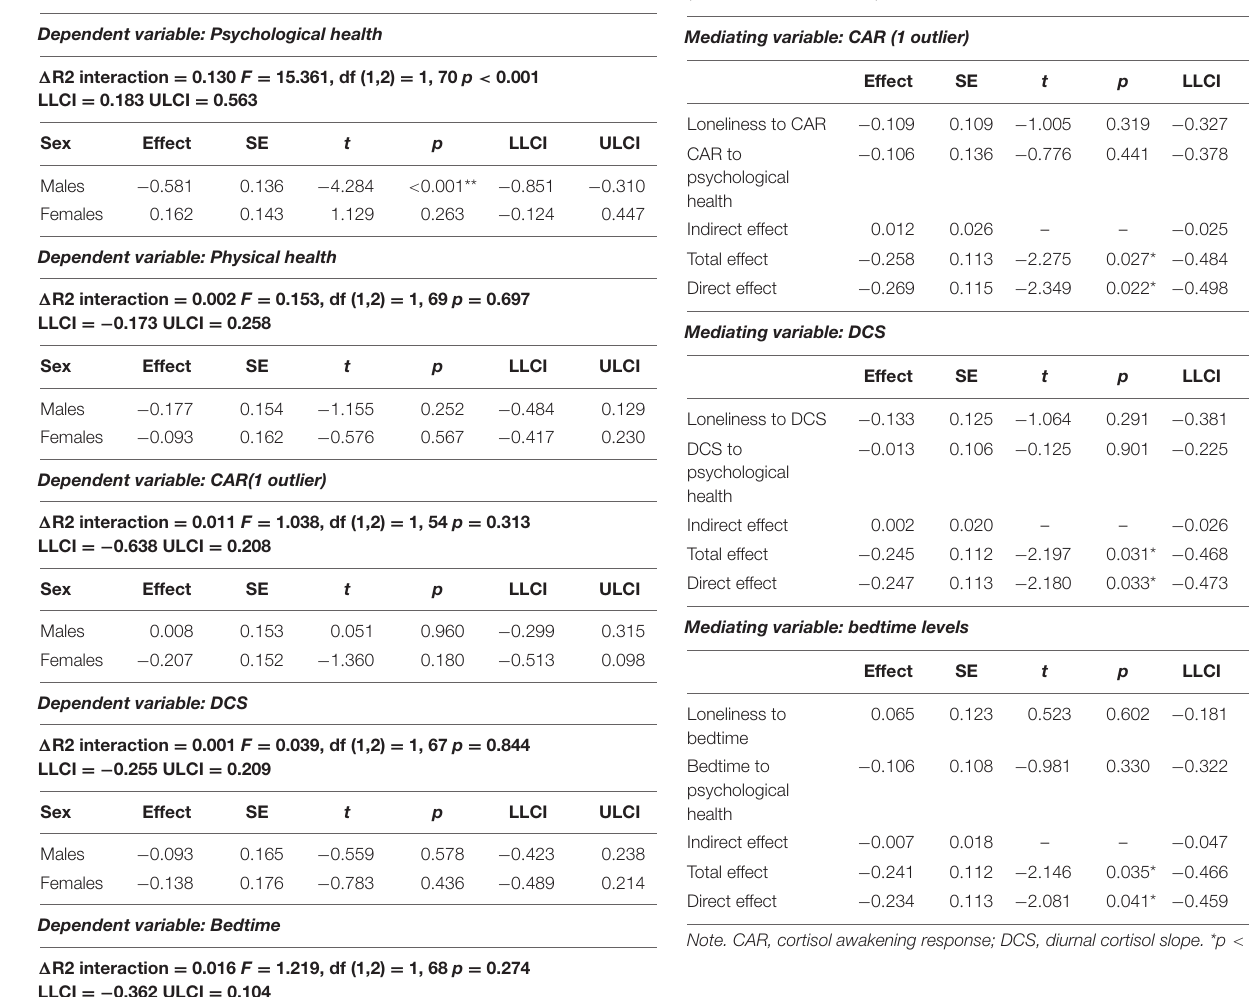
TABLE 5 | Adjusted mediation models of the relationship between loneliness as predictor and psychological health as dependent variables via cortisol indexes (CAR, DCS, and